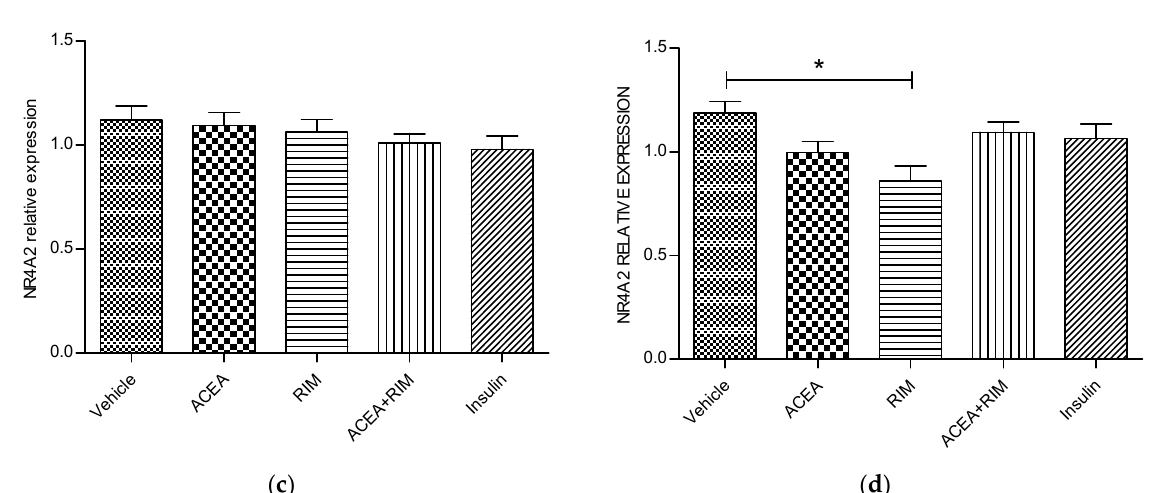
Figure 3. NR4A2 muscle myotubes—ACEA, rimonabant, ACEA and rimonabant, and insulin affect NR4A2 gene expression; myotubes fed with delipidated serum. The stimulation time covered 3 to 24 h, and NR4A2 mRNA levels, relative to TATA-Box, was evaluated by quantitative real-time PCR (qRT-PCR) (100 nM). The following scenarios explain the stimulation process conducted: ( a ) Stimulation was done for 1 h. ( b ) Stimulation was done for 3 h. ( c ) Stimulation was applied for up to 5 h. ( d ) Stimulation was applied for up to 24 h. The data were reported as the mean ± SEM of three separate groups. (n = 3; *denotes p < 0.05, **denotes p < 0.01, and ***denotes p < 0.001). Data were investigated by conducting one-way ANOVA test and Tukey test. NR4A2; nuclear receptor subfamily 4, group A, member 2.